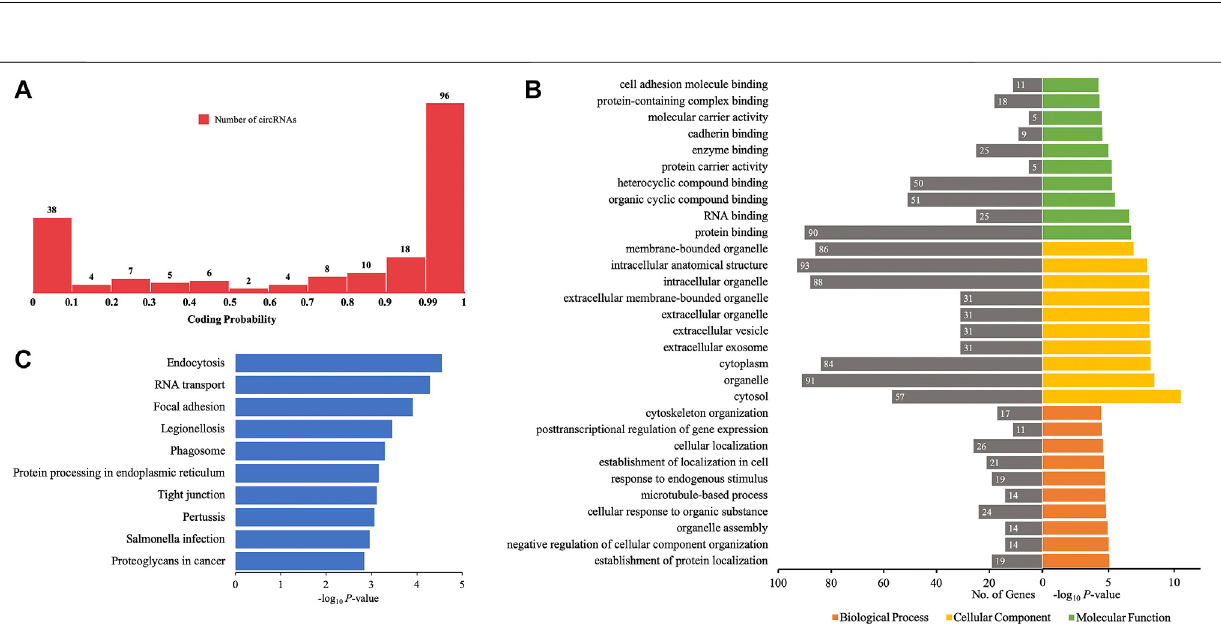
Frontiers in Genetics |